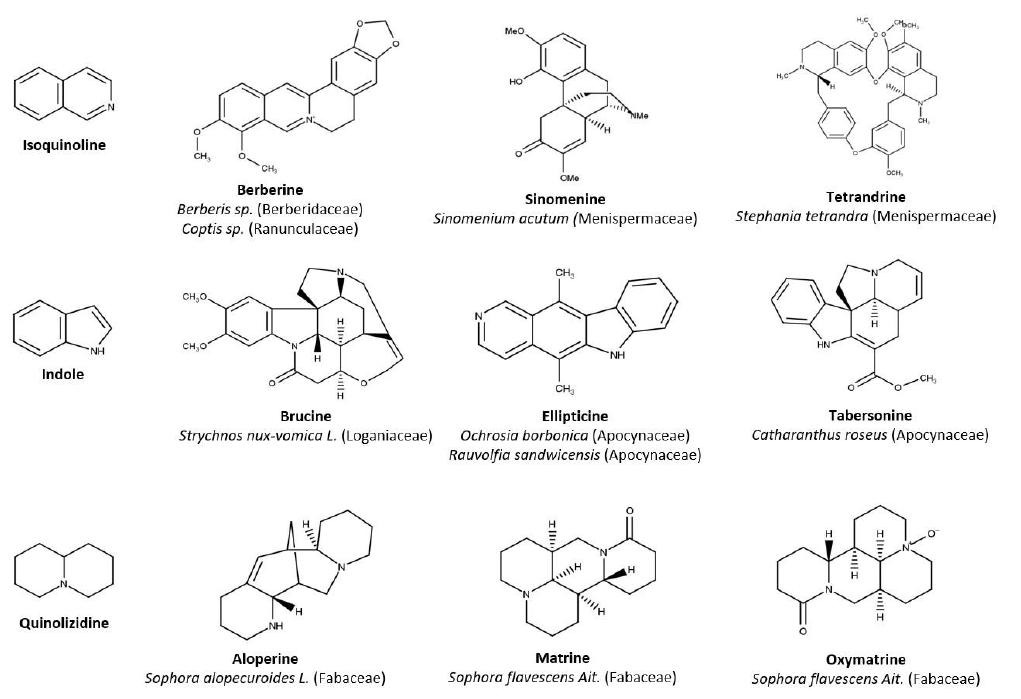
Figure 2. Chemical structures of the selected isoquinoline-, indole- and quinolizidine-derived alka- loids with their common botanical sources. Molecules were drawn using MarvinSketch.